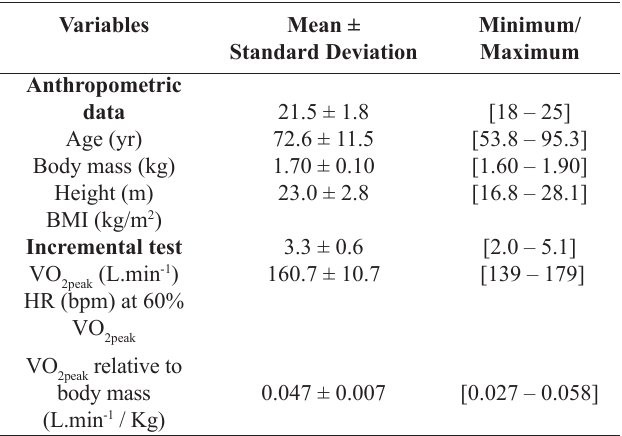
Table 1. Subject characteristics.